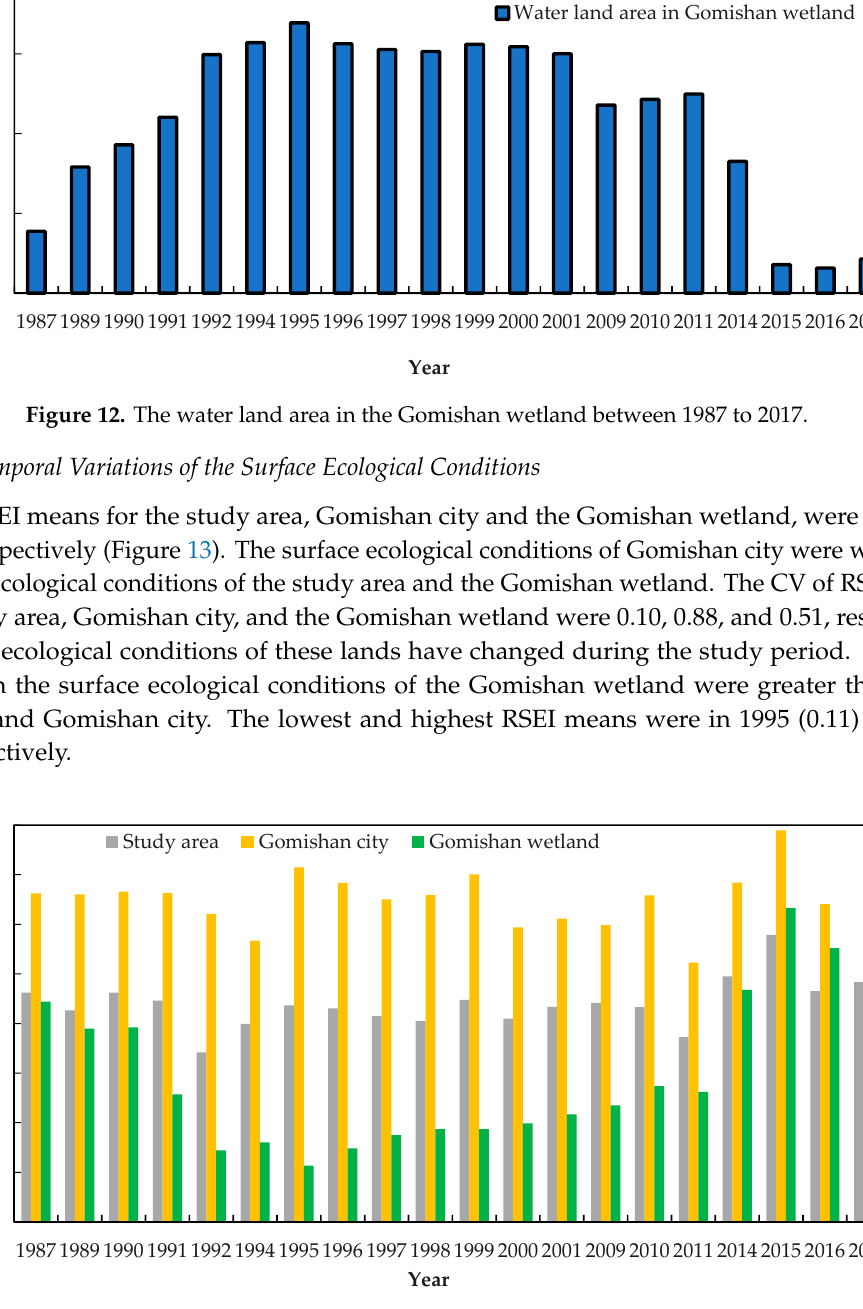
Figure 14. The r between the water land areas in the Gomishan wetland and the RSEI means for the Gomishan wetland and the study area between 1987 to 2017. A visual survey of classified RSEI maps shows that the spatial distribution of surface ecological conditions varies at different dates (Figure 15). The areas covered with bare soil have poor surface ecological conditions, and the areas covered with water have excellent surface ecological conditions. With the retreat of water from the Gomishan wetland between 1987 and 2017, the surface ecological conditions of this part of the region have changed from excellent and very good to good .